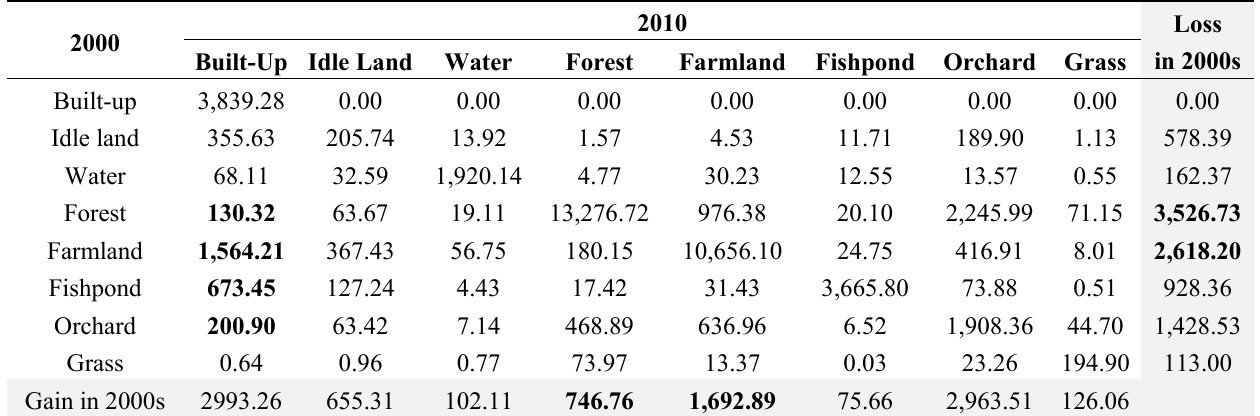
Table 6. Land use Conversion during